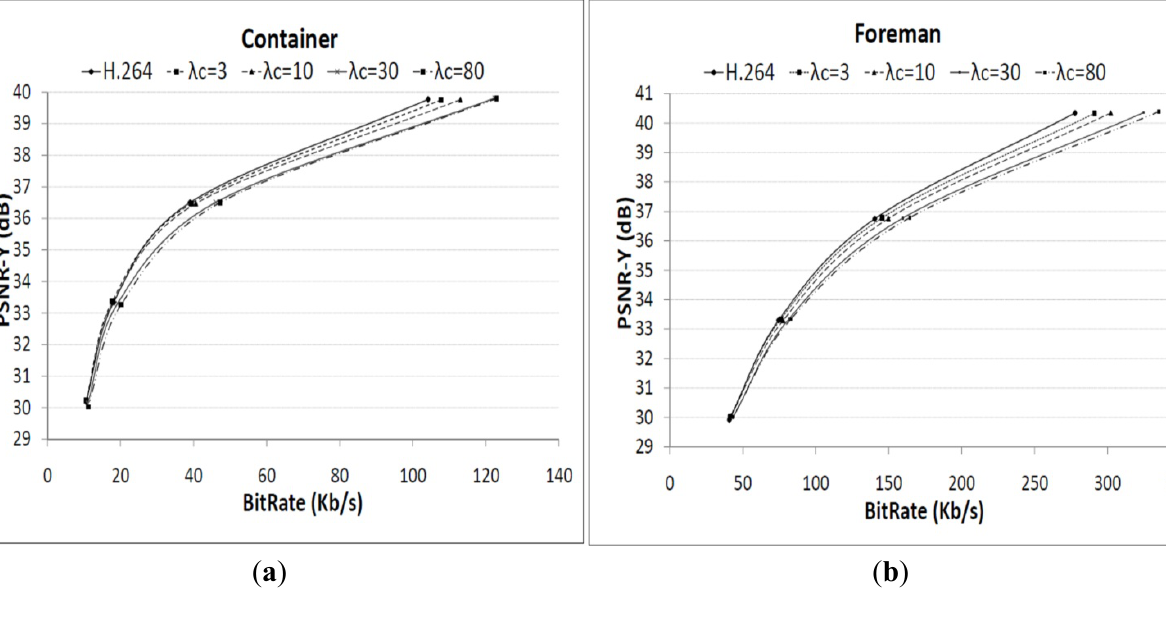
Figure 7. Rate-PSNR performance for different values of (cid:2245)